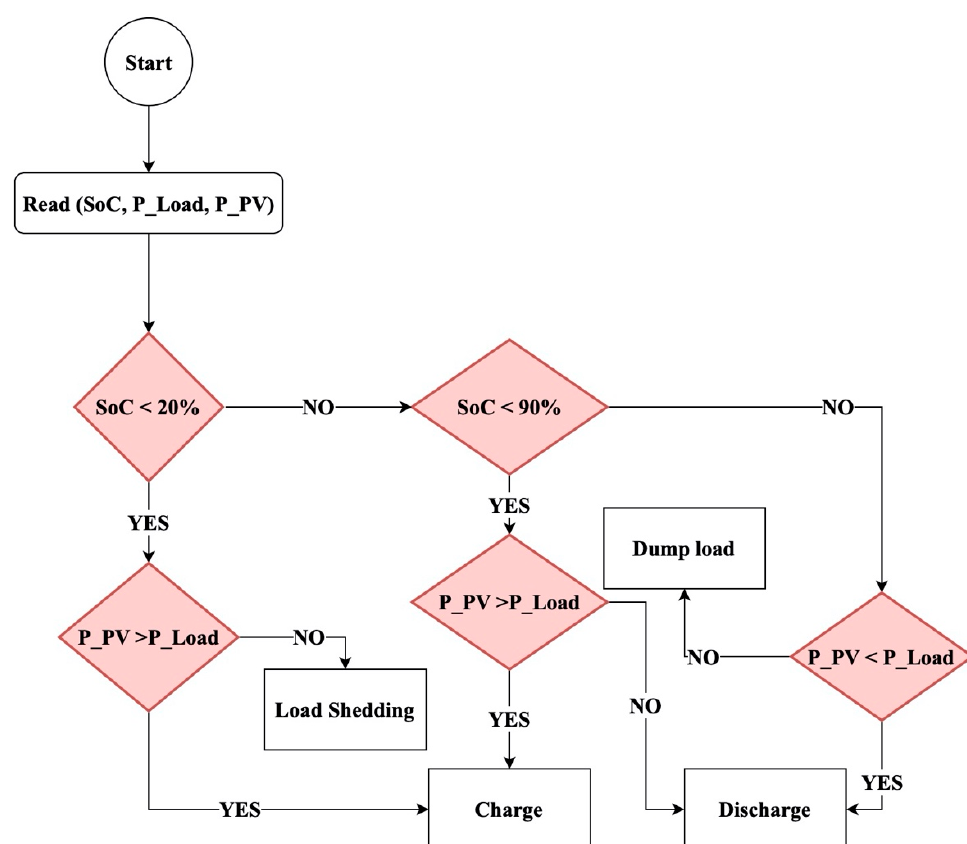
Figure 12. Battery controlling strategy.